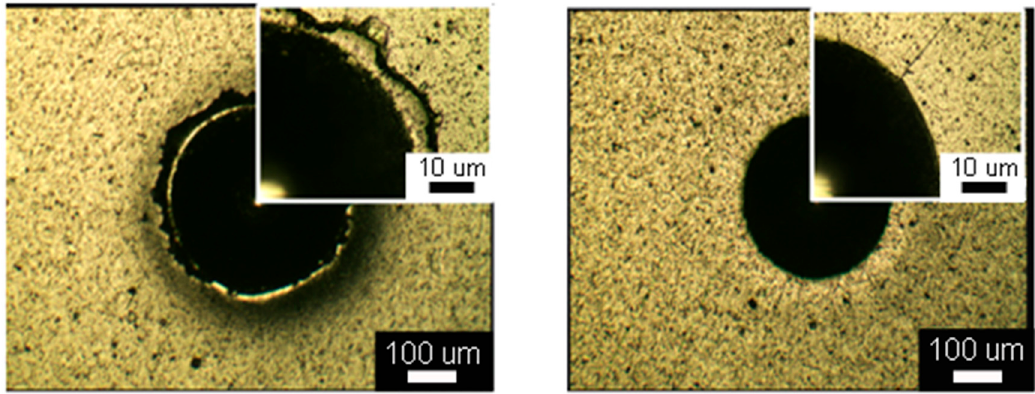
Figure 5. Optical images showing crack behavior evaluated by Rockwell indentation test applied on the AlCrSiN ( Left ) and PN + AlCrSiN ( Right ) coated samples.